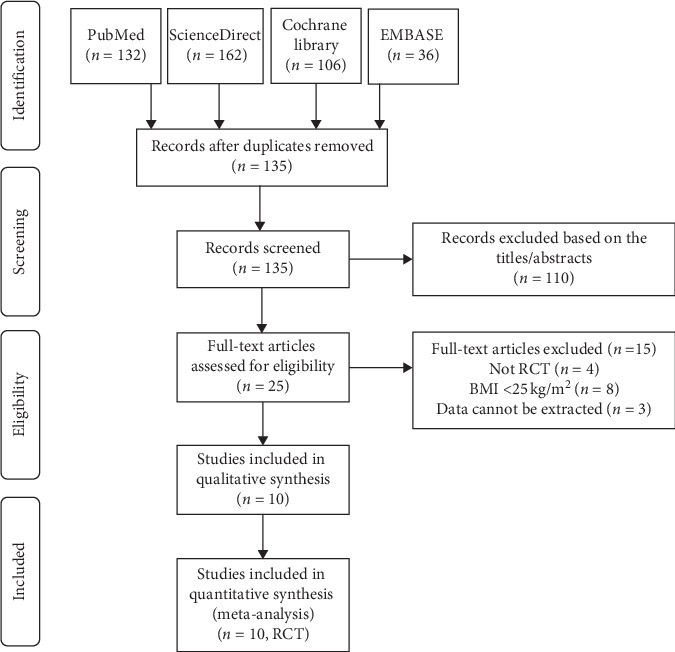
Flow diagram of the study selection process for the meta-analysis.